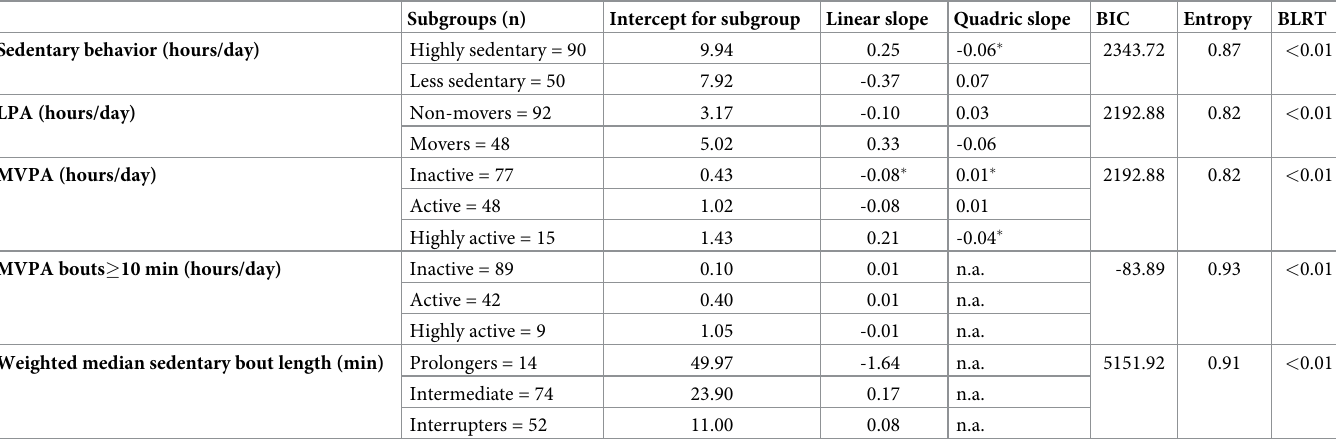
Table 3. Model fit indices for the selected subgroup trajectories for each movement behavior outcome, n = 140. Subgroups